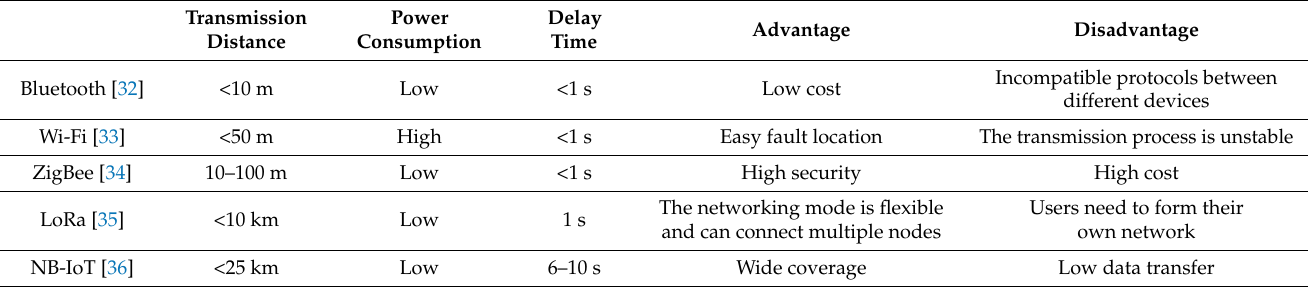
Table 1. Comparison of data transmission technologies commonly used in agricultural